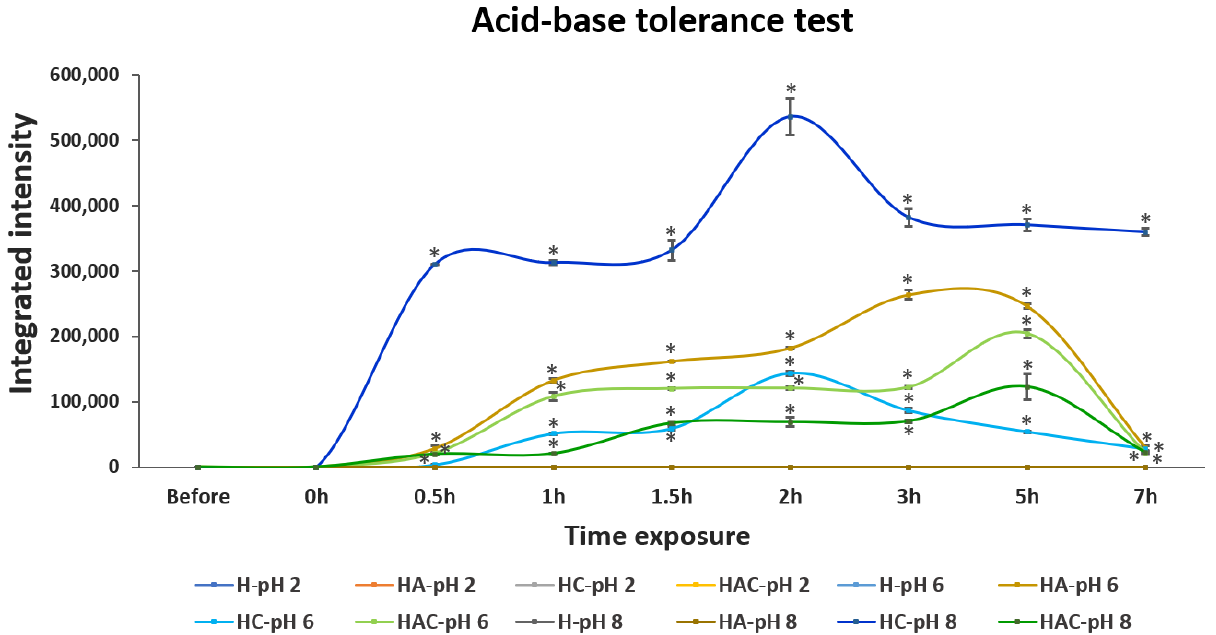
Figure 2. The integrated intensity profile of S. agalactiae protein-lysate-loaded HNTs while exposing them to acid–base solutions at pH 2, pH 6 and pH 8 for 7 h. H, HA, HC and HAC indicate the protein releasing profiles of HNT, HNT-APTES, HNT-Chitosan and HNT-APTES-Chitosan, respectively. Notably, the releasing profile of Strep proteins in pH 2 of all Strep-loaded HNT formulations, including H-pH 6, H-pH 8 and HA-pH8, were non-detectable (n.d.). Statistical analysis was performed via a paired two-sample t -test for an analysis of means with p < 0.05. “*” indicates that the HA-pH6, HC-pH6 and HAC-pH6 were significantly different from H-pH6 and that HC-pH8 and HAC-pH8 were significantly different from